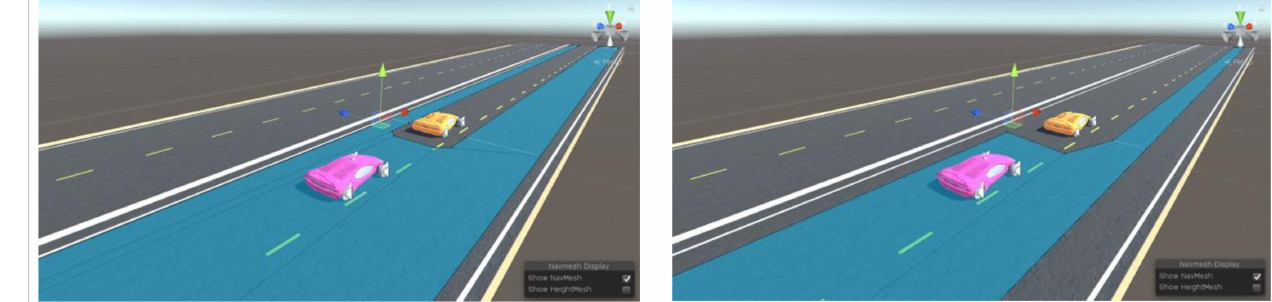
Figure 14. Simulation results of changing the safe distance on navigation area around the